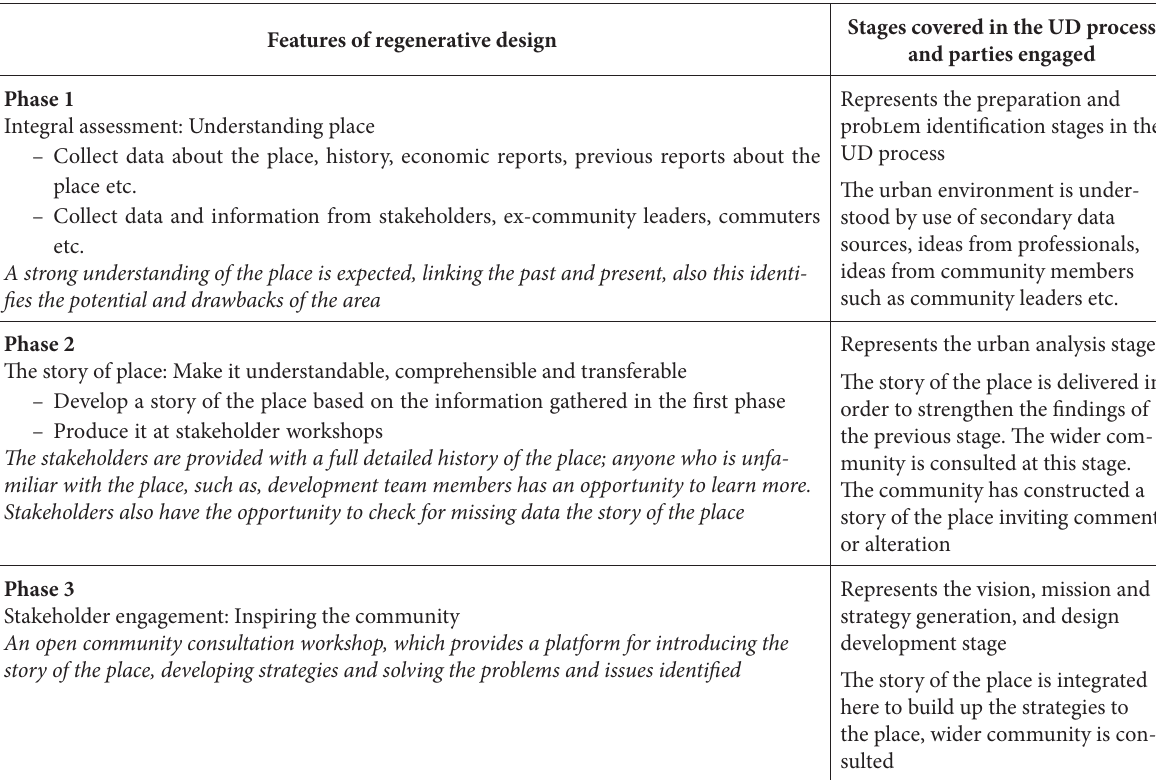
Figure 1. Key stages of urban design process under the specific features of regenerative design